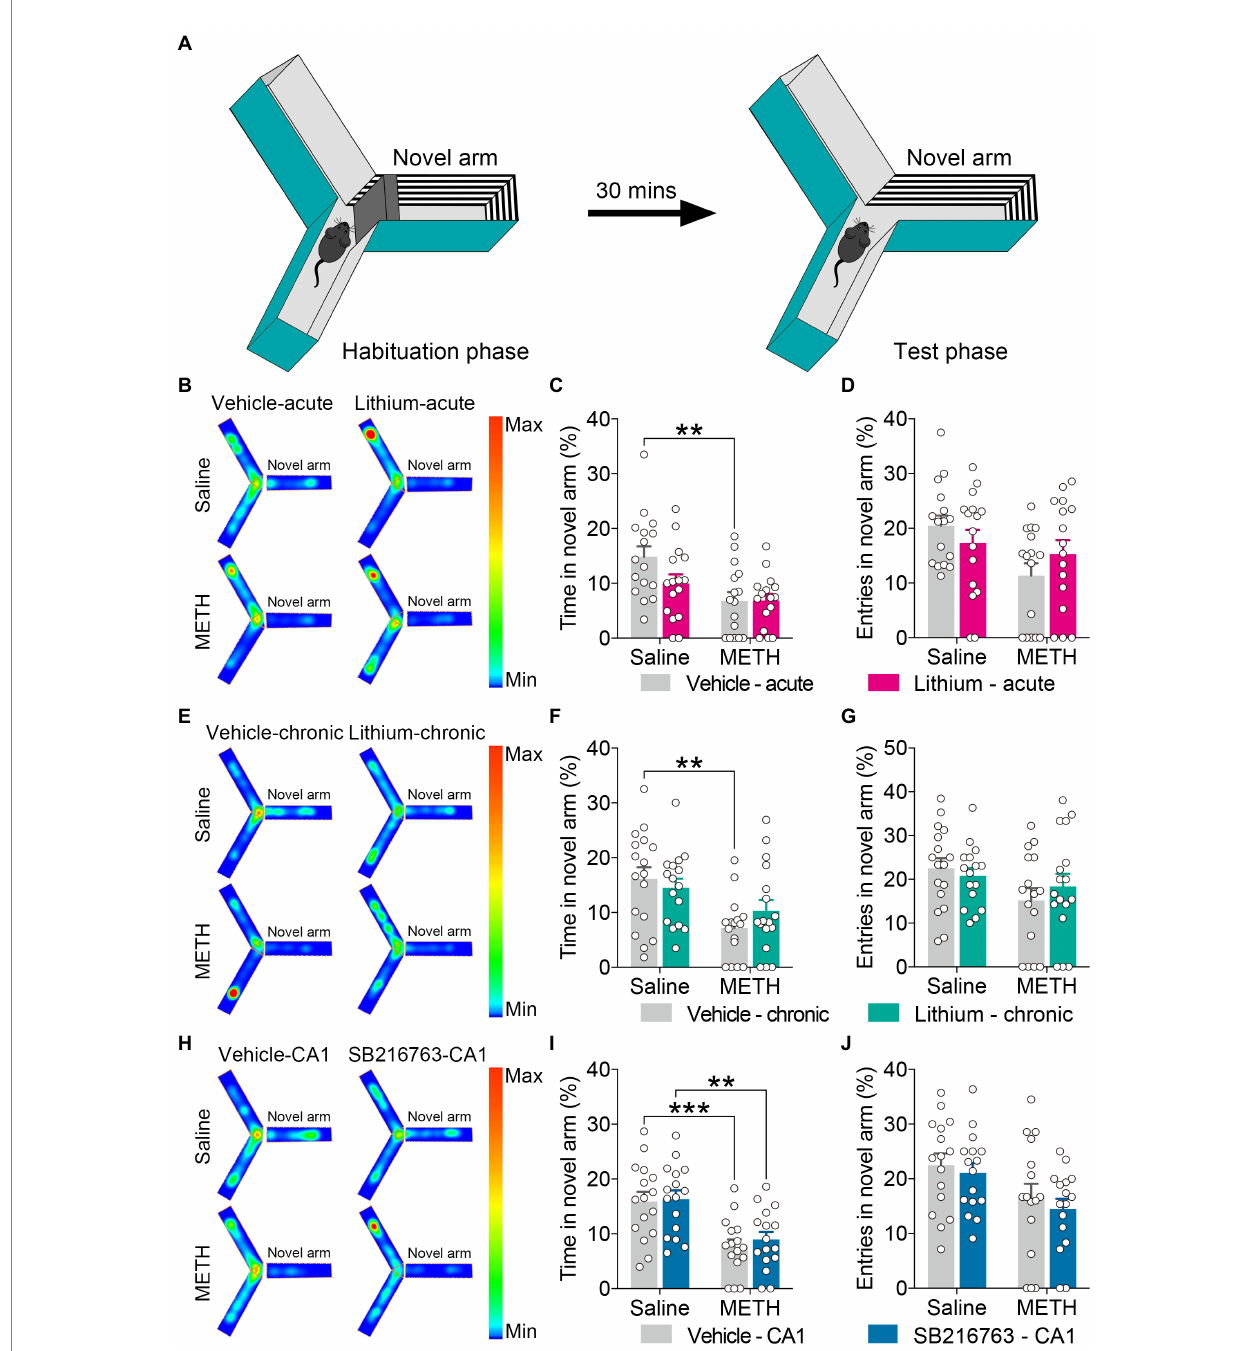
FIGURE 3 Effect of GSK3 β inhibition on adolescent METH exposure-induced novel spatial exploration impairment in adulthood. Apparatus and placements of the mice for the modified two-trial Y-maze test (A) . There was no significant influence by the acute systemic intervention (B–D) , chronic systemic intervention (E–G) , or chronic intervention within CA1 (H–J) in adolescent METH exposure-induced novel spatial exploration impairment in adulthood. Representative heat maps show the location of the mice during the testing phase (B,E,H) . Histograms show the time spent (%) (C,F,I) and entries (%) (D,G,J) in the novel arm in this test. Data are presented as the mean +/ − SEM, each symbol represents the independent of a single animal; two-way ANOVA followed by the Bonferroni post hoc test; n = 16 ~ 17/group; ** p < 0.01 and *** p < 0.001, comparison between the two indicated groups. See also Supplementary Figure